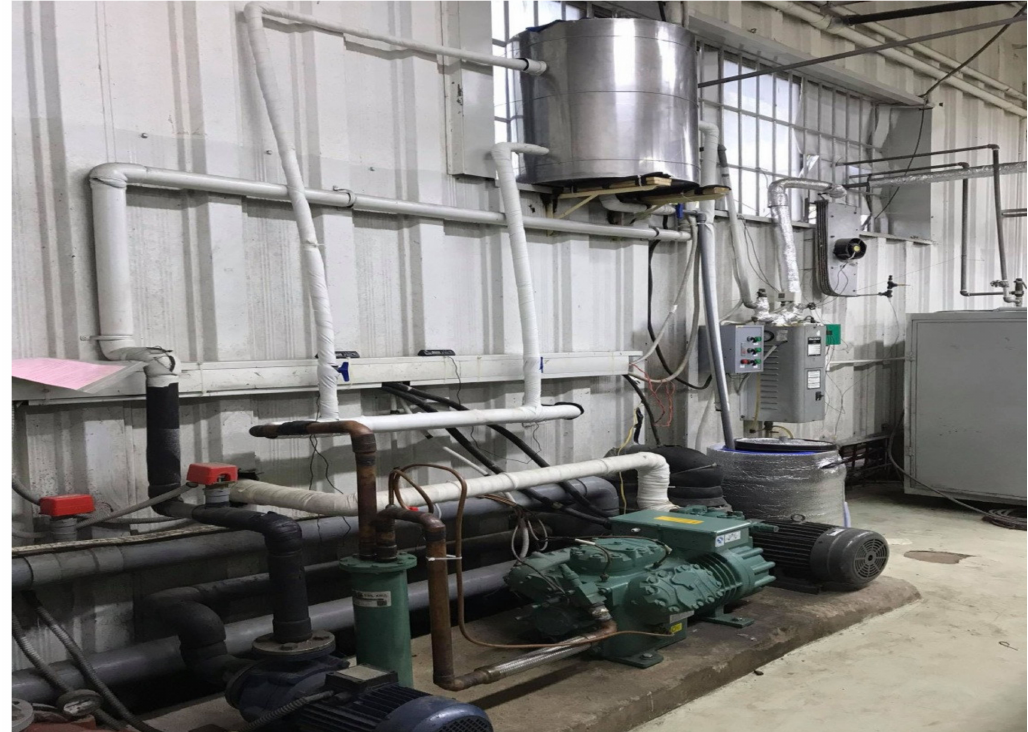
Figure 7. Photograph of the thermal storage tank integrated into the